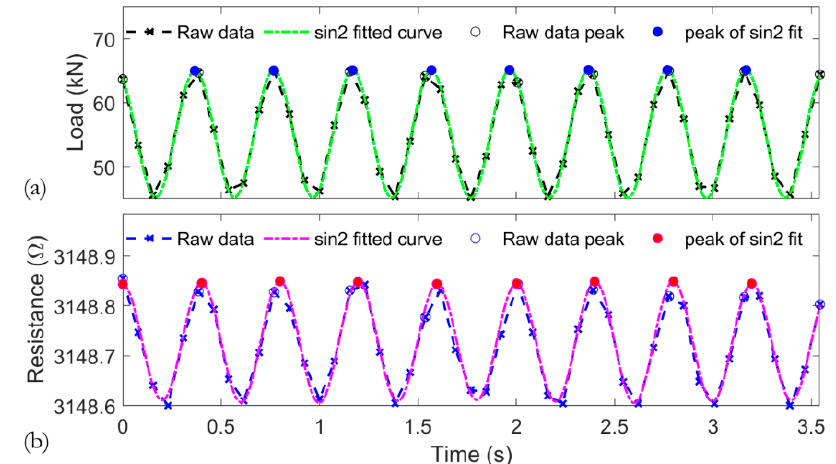
Figure 6. Sample data with selected peaks for both raw and sine curve-fitted data: ( a ) load vs. time and ( b ) resistance vs. time.